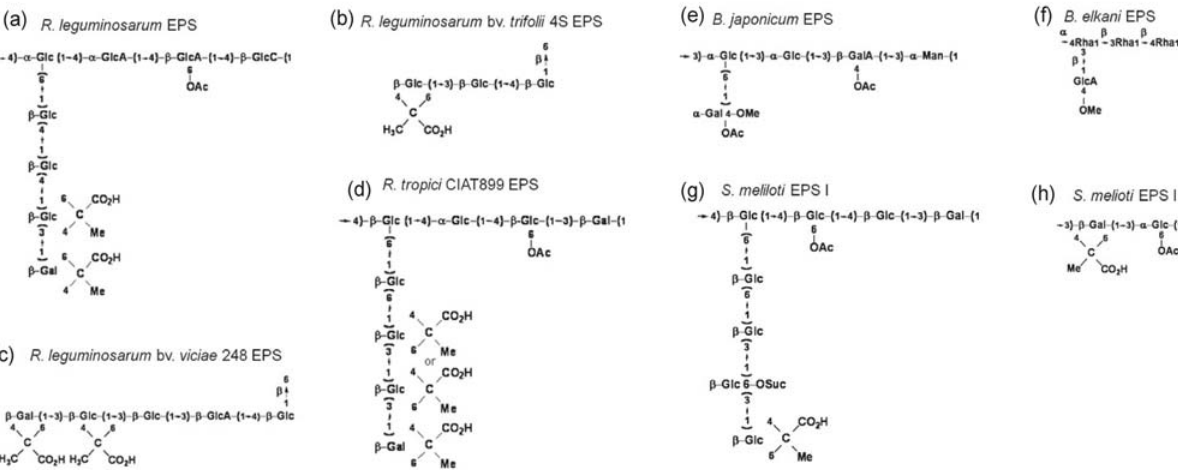
Figure 2. Primary EPS structure of different rhizobia species (a) Rhizobium leguminosarum (Robertsen et al., 1981; O’Neil et al., 1991), (b) R. leguminosarum bv. trifolii 4S (Amemura et al., 1983), (c) Rhizobium leguminosarum bv. viciae 248 (Canter-Cremers et al., 1991), (d) Rhizobium tropici CIAT899 T (Gil-Serrano et al., 1990), (e) Bradyrhizobium japonicum (Mort & Bauer 1980, 1982; Huber et al., 1984; Puvanesarajah et al., 1987; Louch & Miller, 2001), (f) Bradyrhizobium elkani (Huber et al., 1984; An et al., 1995), (g) Sinorhizobium meliloti EPS I (Leigh et al., 1985; Reinhold et al., 1994), (h) Shinorhizobium meliloti EPS II (Zhan et al., 1989; Her et al., 1990). Glc: glucose; Gal: galactose; GlcA: glucouronic acid; GalA: galactouronic acid; Mn: manose; Rha: rhamnose; Suc: succinate; Ac: